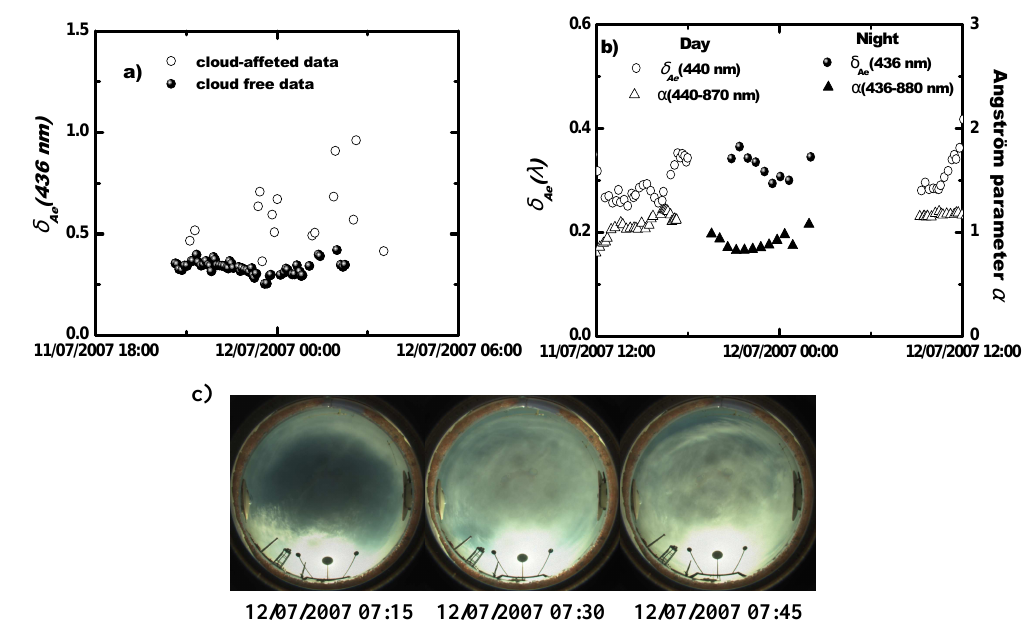
Fig. 8. (a) Nighttime evolution of aerosol optical depth during Mediterranean air masses influence over the city of Granada on the night 11– 12 July 2007. (b) Day-and-night time evolution of aerosol optical depth and Angstr¨om parameter α from 11 to 12 July 2007, after applying the cloud screening algorithm presented in this work to the nighttime data. (c) All-sky images during the early morning of 12 July 2007 (times expressed in